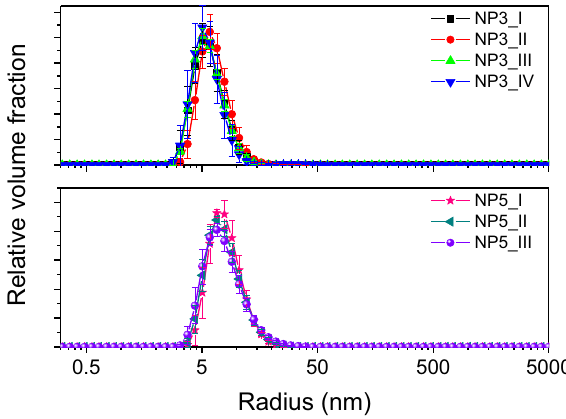
Figure 4. Volume-weighted size distributions for the NP3 (upper) and NP5 (lower) series derived from the DLS measurements. Each presented data set is an average of typically 10 individual measurements recorded